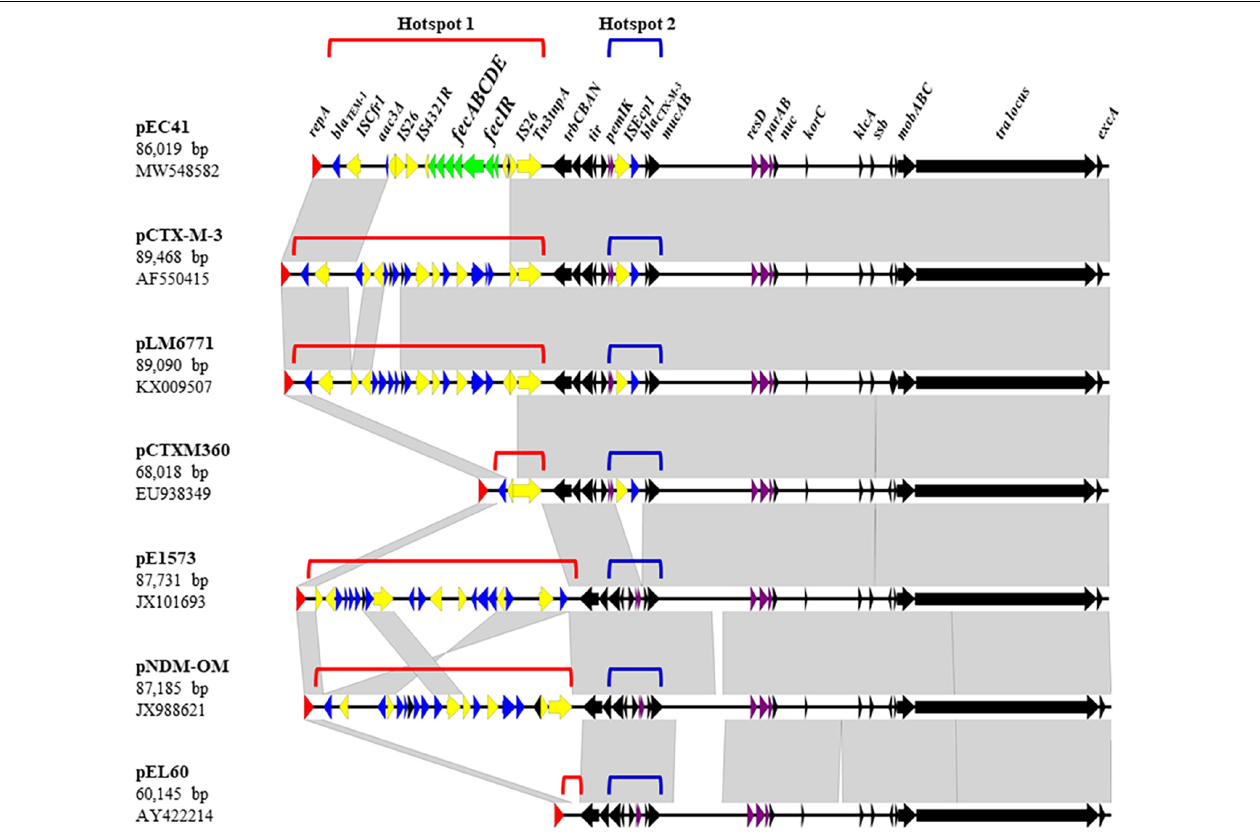
FIGURE 2 | Linear comparison of pEC41 with other IncM group plasmids. Black arrows indicate the common regions shared among the plasmids. The tra locus contains tra genes involved in conjugal transfer. The partition system ( parAB ) and postsegregational killing system ( pemIK ) are indicated by purple arrows. Resistance genes are indicated by blue arrows. Insertion sequences and transposon components are indicated by yellow arrows. The fec system on pEC41 is indicated with green arrows. The replicase gene repA is indicated by red arrows. The direction of arrows indicates the direction of the ORF. Gray shading denotes regions of shared homology among different plasmids. Diagrams were drawn from sequences available under the following GenBank accession numbers: pEC41 (MW548582), pCTX-M-3 (AF550415), pLM6771 (KX009507), pCTXM360 (EU938349), pEl1573 (JX101693), pNDM-OM (JX988621), and pEL60 (AY422214). The comparison map was generated using Easyfig software (Sullivan et al.,